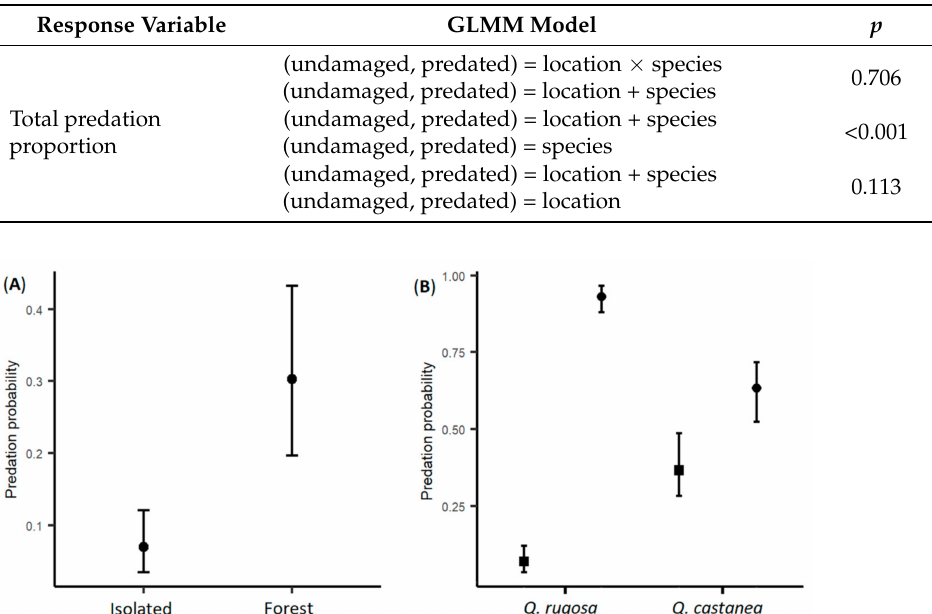
Table 1. Generalized linear mixed effects models (GLMMs) used to analyze predation probability of acorns of two Quercus species. In each model the effects of tree location and Quercus species were included. The p -values indicate the significance of the likelihood ratio test among pairs of models ( n = 1186).